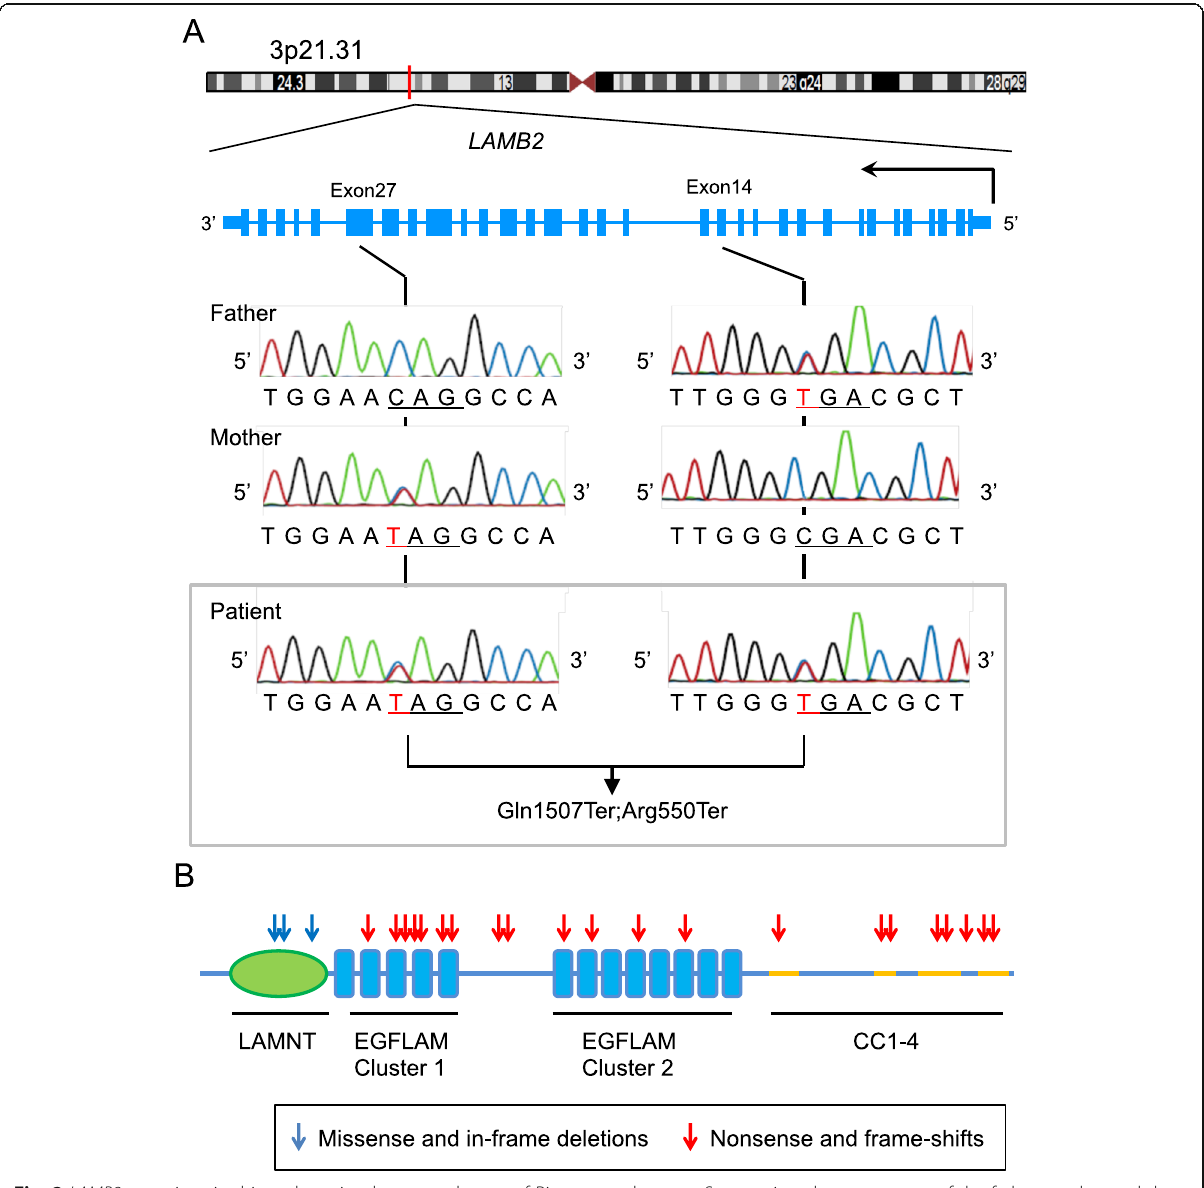
Fig. 2 LAMB2 mutations in this and previously reported cases of Pierson syndrome. a Sequencing chromatograms of the father, mother and the patient are shown. The 5 ′ to 3 ′ ends of the transcripts are indicated in combination with each diagram. Vertical arrows indicate the position of mutations; exon14 (c.1648C > T:p.Arg550X) and exon 27 (c.4519C > T:p.Glu1507X), and mutated codons are underlined. b Pathogenic mutations associated with the neuromuscular symptoms of PS are mapped to the functional domains of Laminin β 2 protein. Red arrows: nonsense and frame-shift mutations; Black arrows: missense mutations and in-frame deletions. LAMNT, laminin N-terminal globular domain; EGFLAM, laminin EGF-like modules; CC, laminin coiled coil